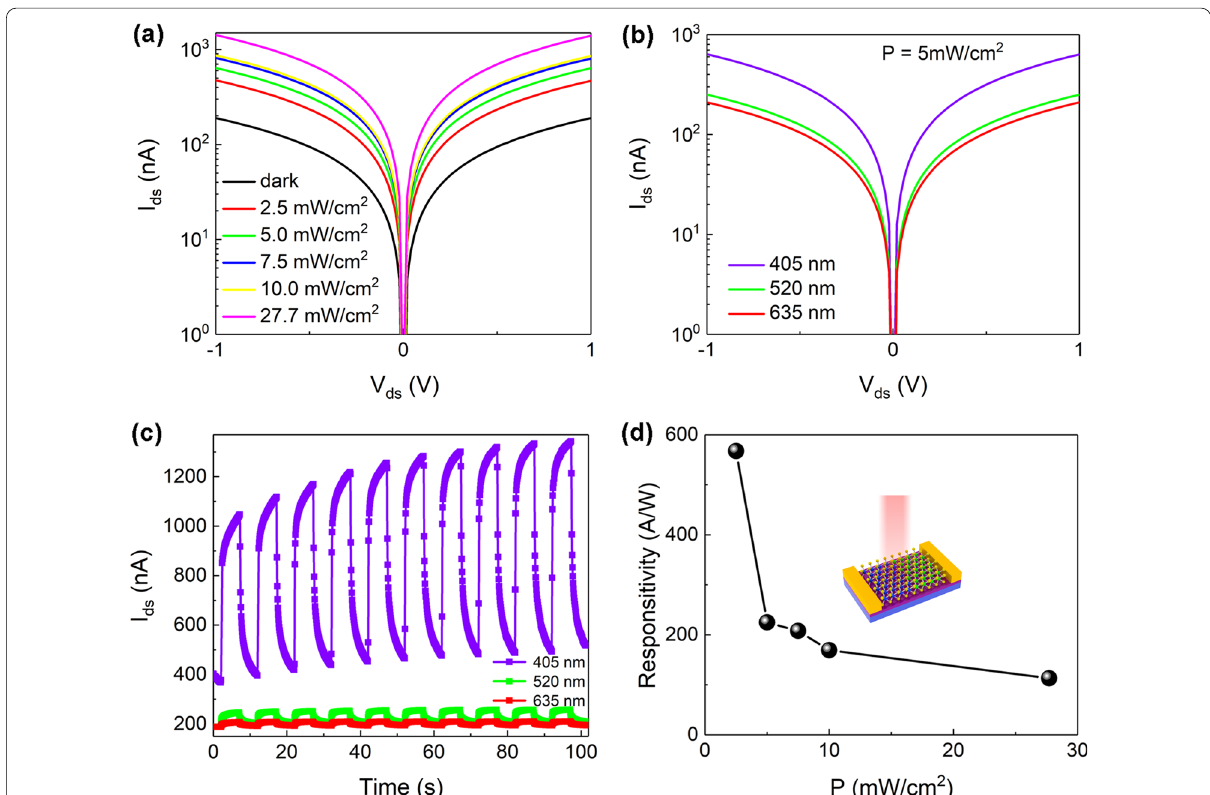
Fig. 3 Photoresponse behavior of the photodetector. The I – V characteristics under different 405 nm laser power densities ( a ) and under different incident wavelengths of 5 mW/cm 2 ( b ). ( c) The time-resolved photoresponse excited by the periodic on/off switching of incident light. ( d) The extracted R (black sphere) as a function of laser power densities. The applied voltage for ( c – d ) is 1